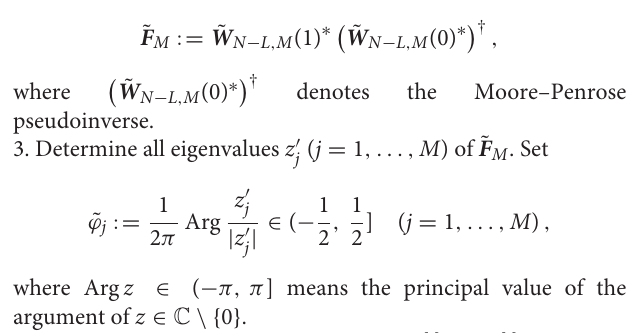
Algorithm 2.8 is relatively insensitive to small perturbations on